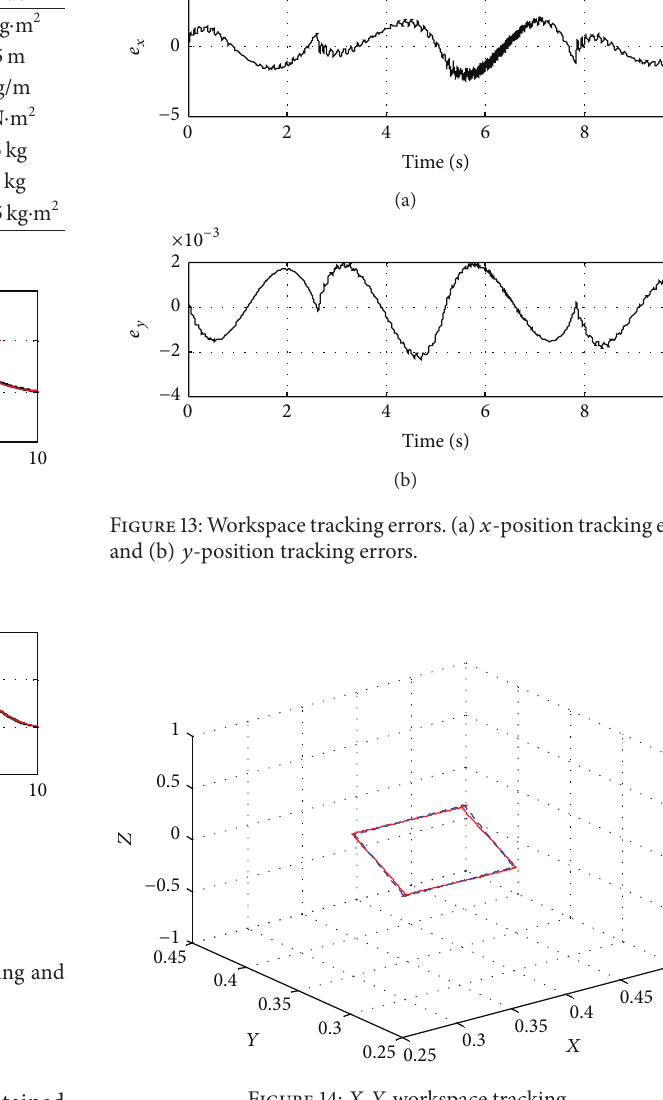
Figure 14: 𝑋 - 𝑌 workspace